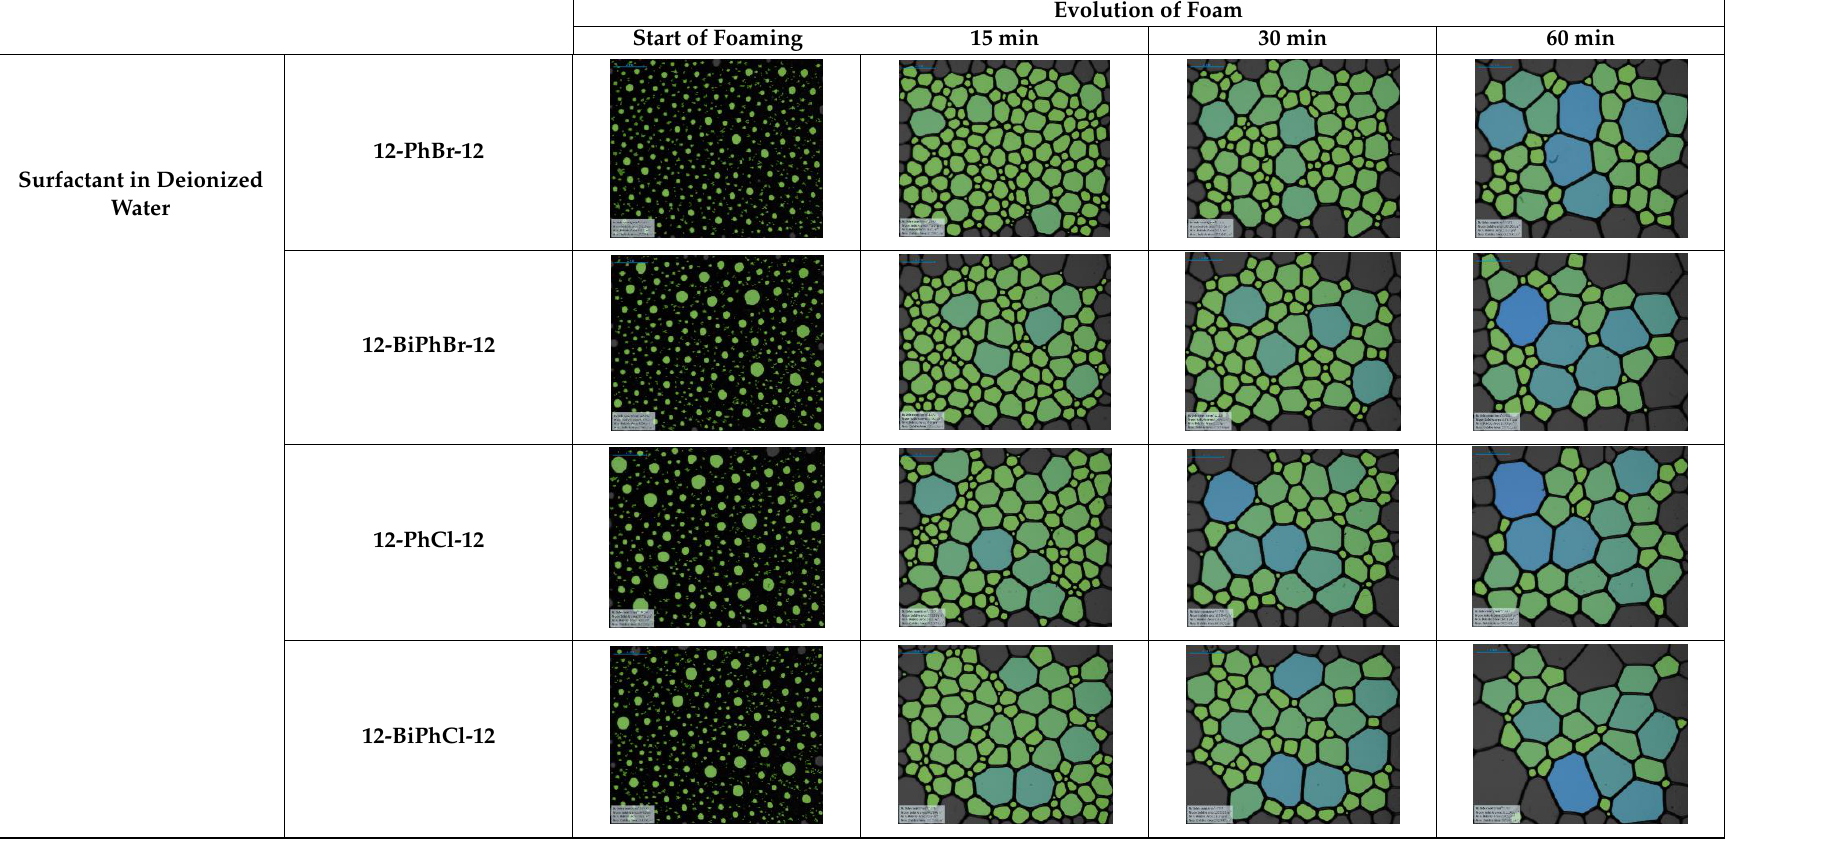
10 of 23 Table 2. Image view of bubble count and size at different times for all surfactants. Evolution of Foam Start of Foaming